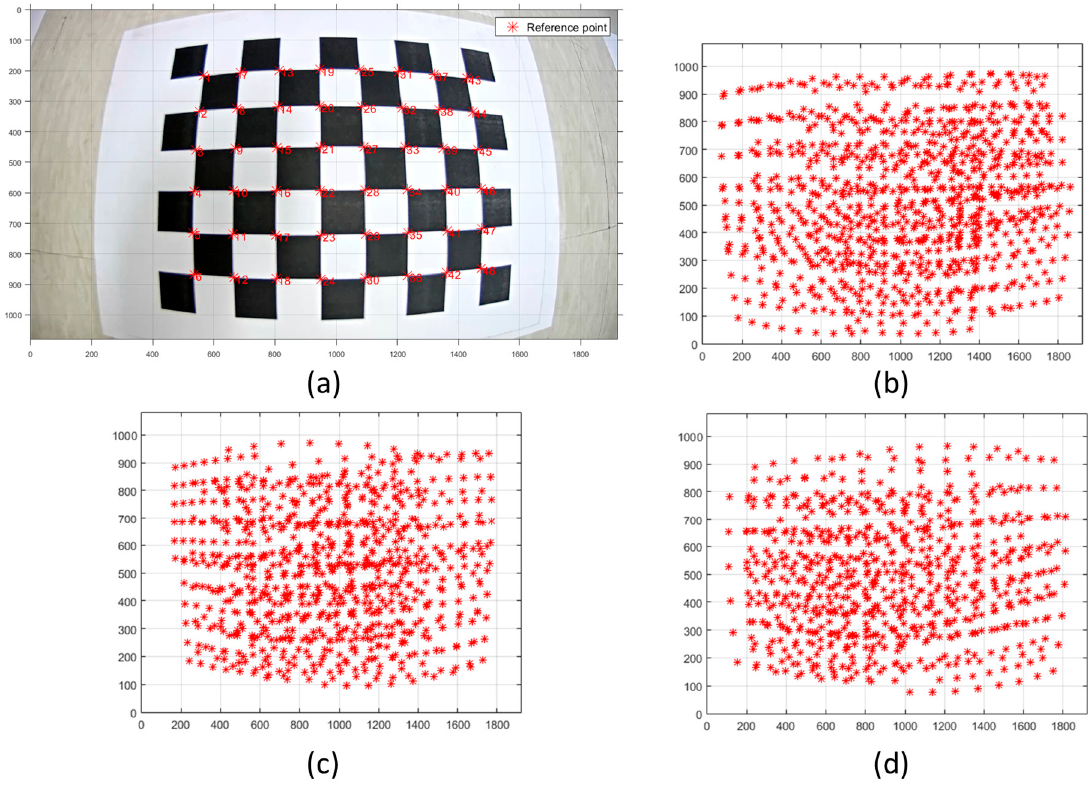
Figure 7. ( a ) Checkerboard and extracted reference points; ( b ) reference points for calibration of CAM(F); ( c ) reference points for calibration of CAM(L); ( d ) reference points for calibration of CAM(R).